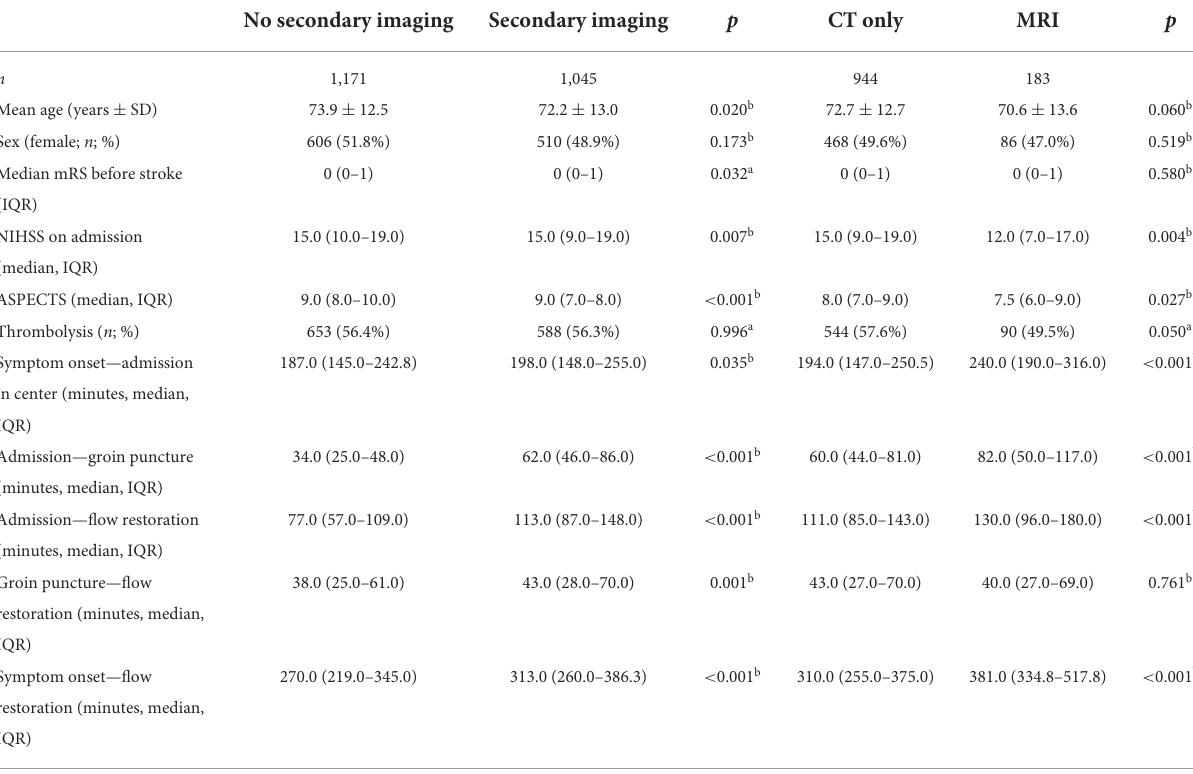
TABLE 4 Baseline characteristics and procedure times of drip-and-ship admissions according to whether secondary imaging was performed and if there was CT only or MRI available. No secondary imaging Secondary